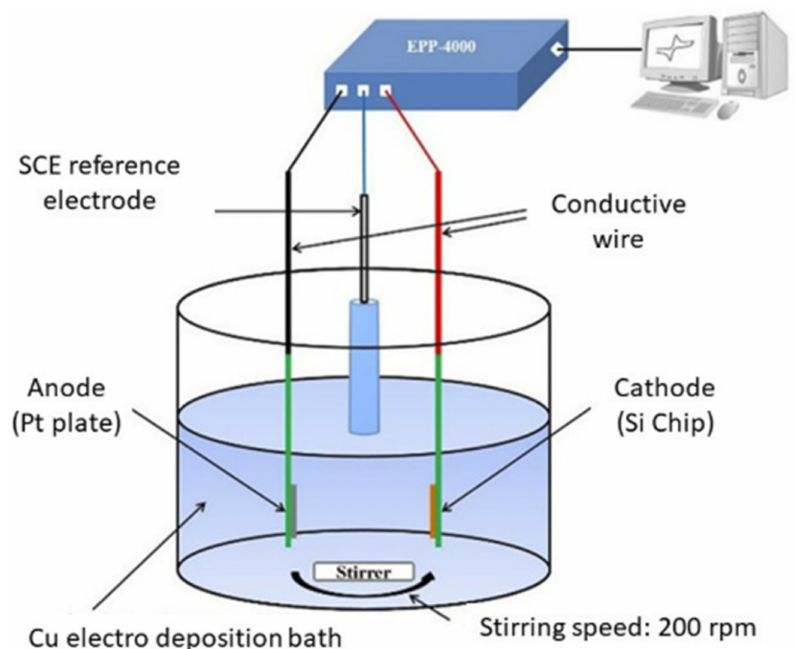
Figure 13. Three-electrode system plating cell. Reprinted with permission from